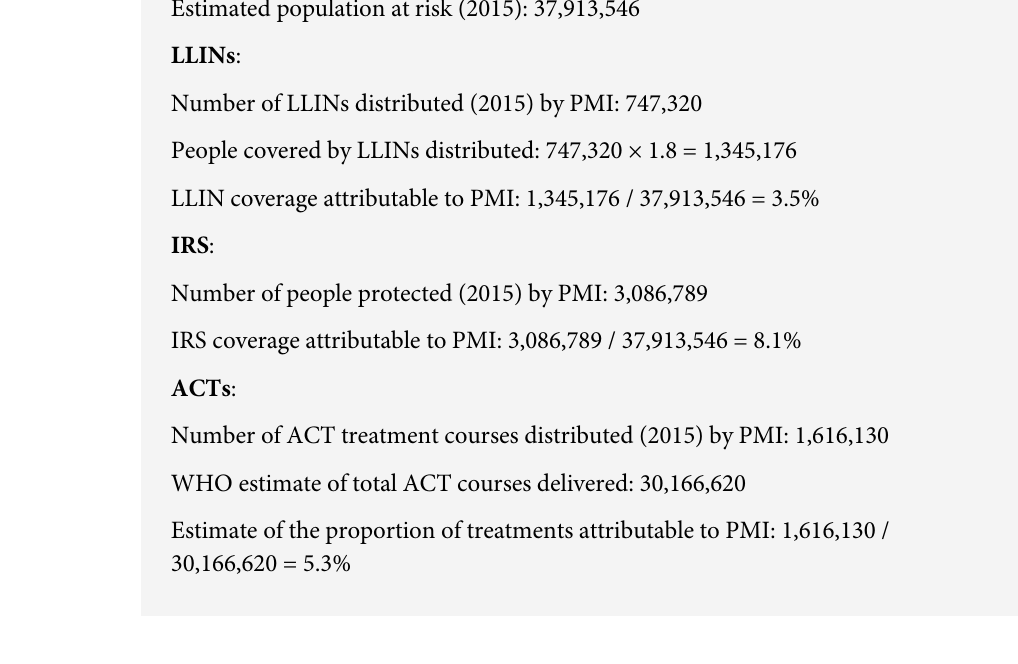
Box 1. Example of estimating future coverage attributable to PMI funding: